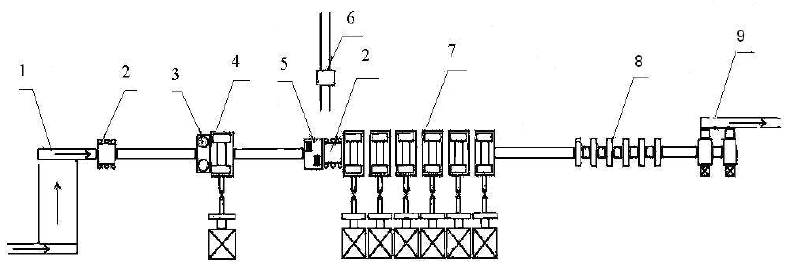
Figure 1. Schematic layout of equipment in the hot strip mill [56]